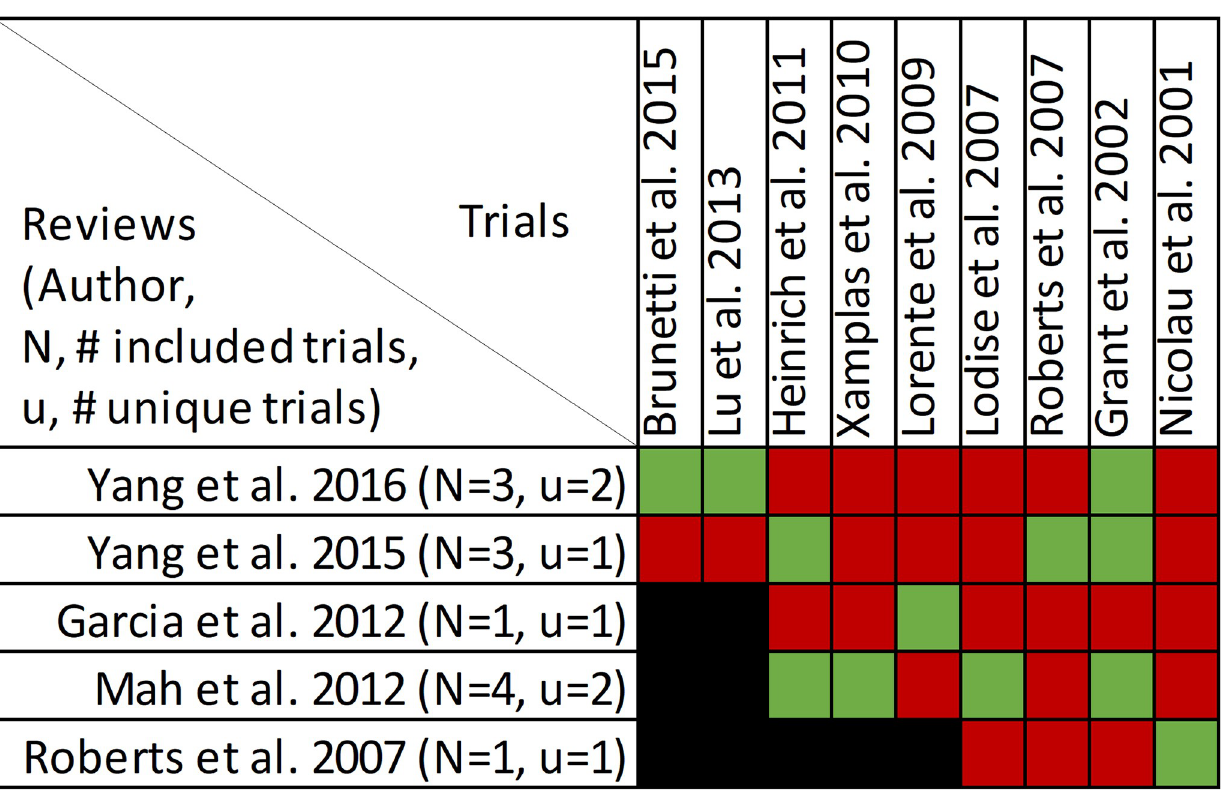
Fig 16. Citation matrix for reviews reporting cost of prolonged versus intermittent infusions of beta-lactams. Green—primary studies included in systematic review, Red—primary study not included in systematic review, Black—primary studies published after systematic review and therefore ineligible for possible